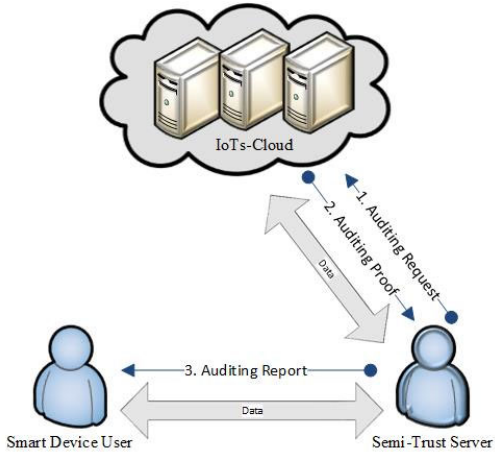
Figure 2. Architecture of the proposed scheme.